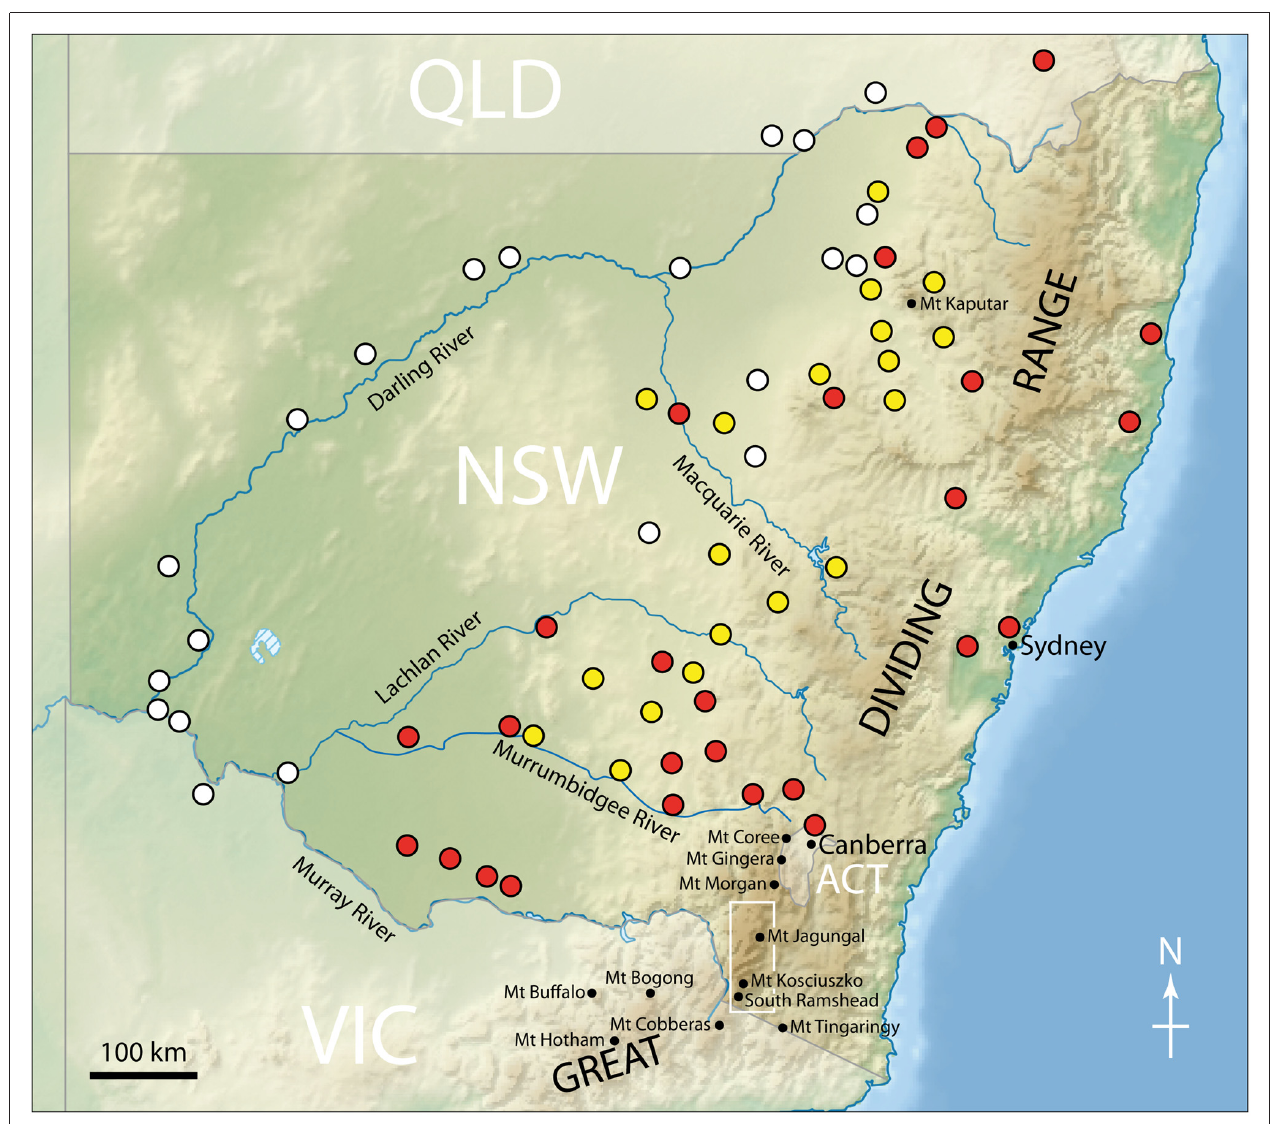
FIGURE 6 | Larval collection locations in southeastern Australia. Collections were made by Froggatt (1900, yellow circles ), Common (1954, red circles ) and Green (2008, white circles ). Also shown are the names of the major rivers in NSW, and the locations of various mountain peaks mentioned in the text. The white box indicates the region of the Snowy Mountains shown in Figure 9 . Redrawn from Green